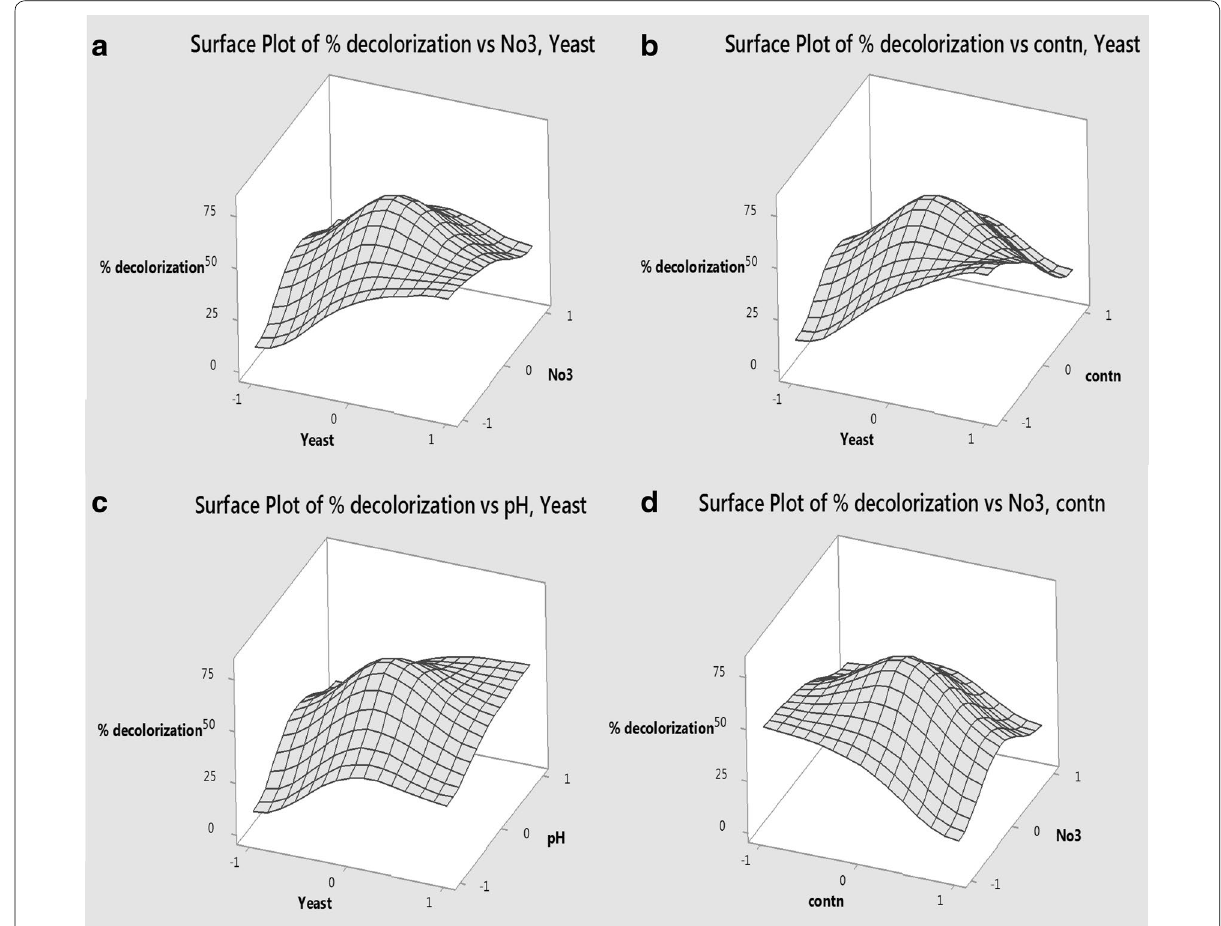
Fig. 7 Three dimensions (3D) surface plots showing the relationship between the most significant factors and their effect on the decolorization of the dye. a 3D surface plot for the effect of yeast extract and nitrate concentration on the decolorization of Remazol black B by isolate B1. b 3D sur- face plot for the effect of yeast extract and dye concentration on the decolorization of Remazol black B by isolate B1. c 3D surface plot for the effect of yeast extract concentration and pH on the decolorization of Remazol black B by isolate B1. d 3D surface plot for the effect of dye and nitrate concentration on the decolorization of Remazol black B by isolate B1